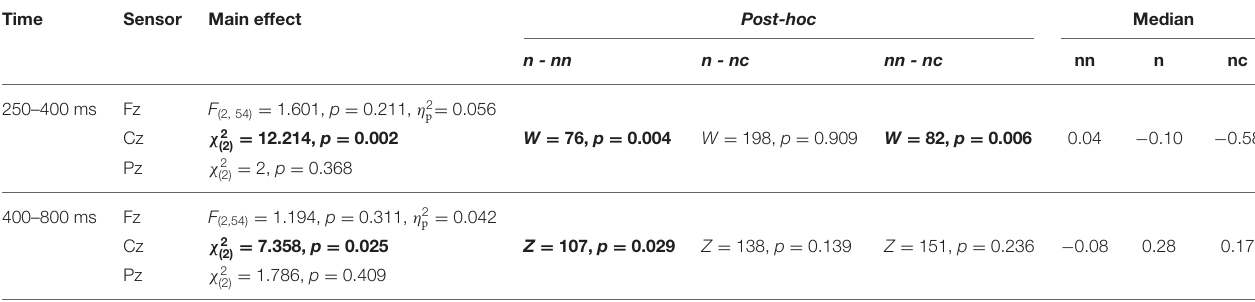
TABLE 2 | Statistical results of event-related potentials (ERPs) with different periods and the three midline